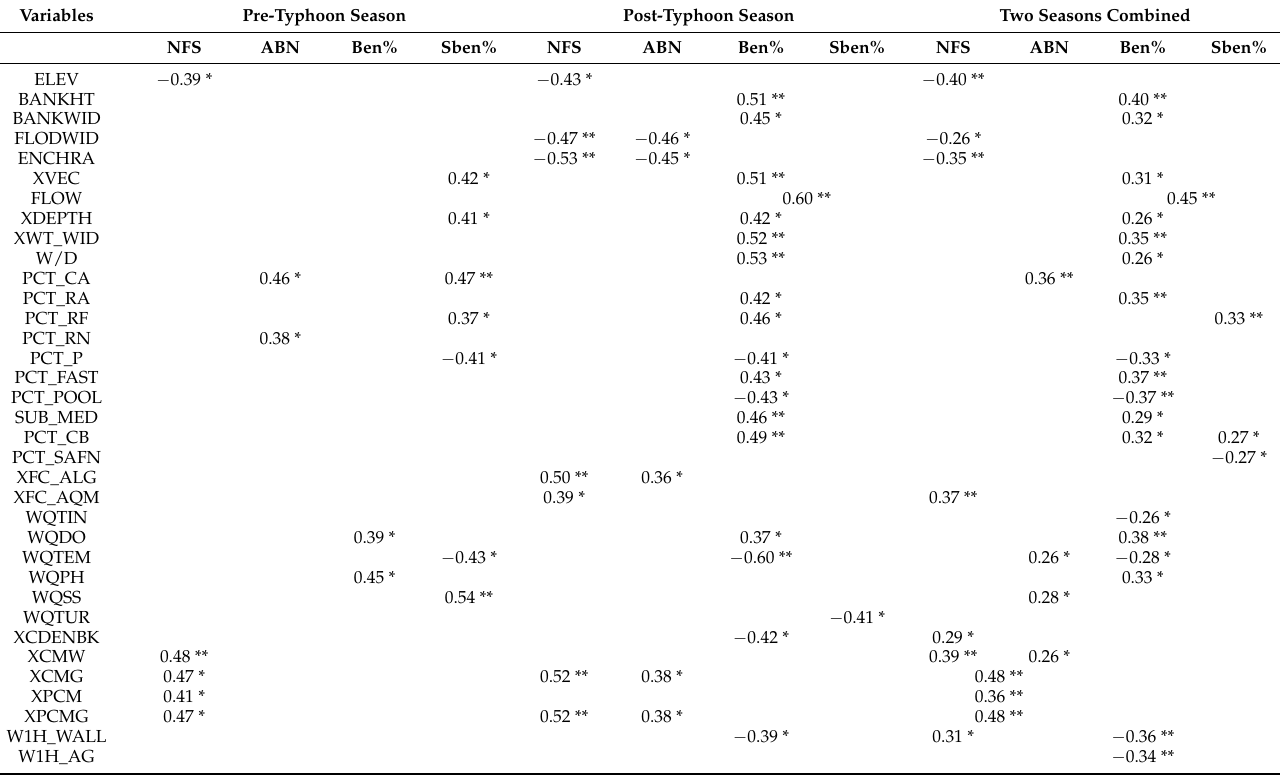
Table 4. Spearman rank correlations between habitat variables and fish metrics significantly differed between the pre-typhoon and post-typhoon seasons. Environmental variables correlated with at least one fish metric were presented. Descriptions of abbreviations of habitat variables are in Table 2, and explanations of abbreviations of fish metrics are in Table 1. * indicates 0.01 < p < 0.05; ** indicates 0.001 < p <